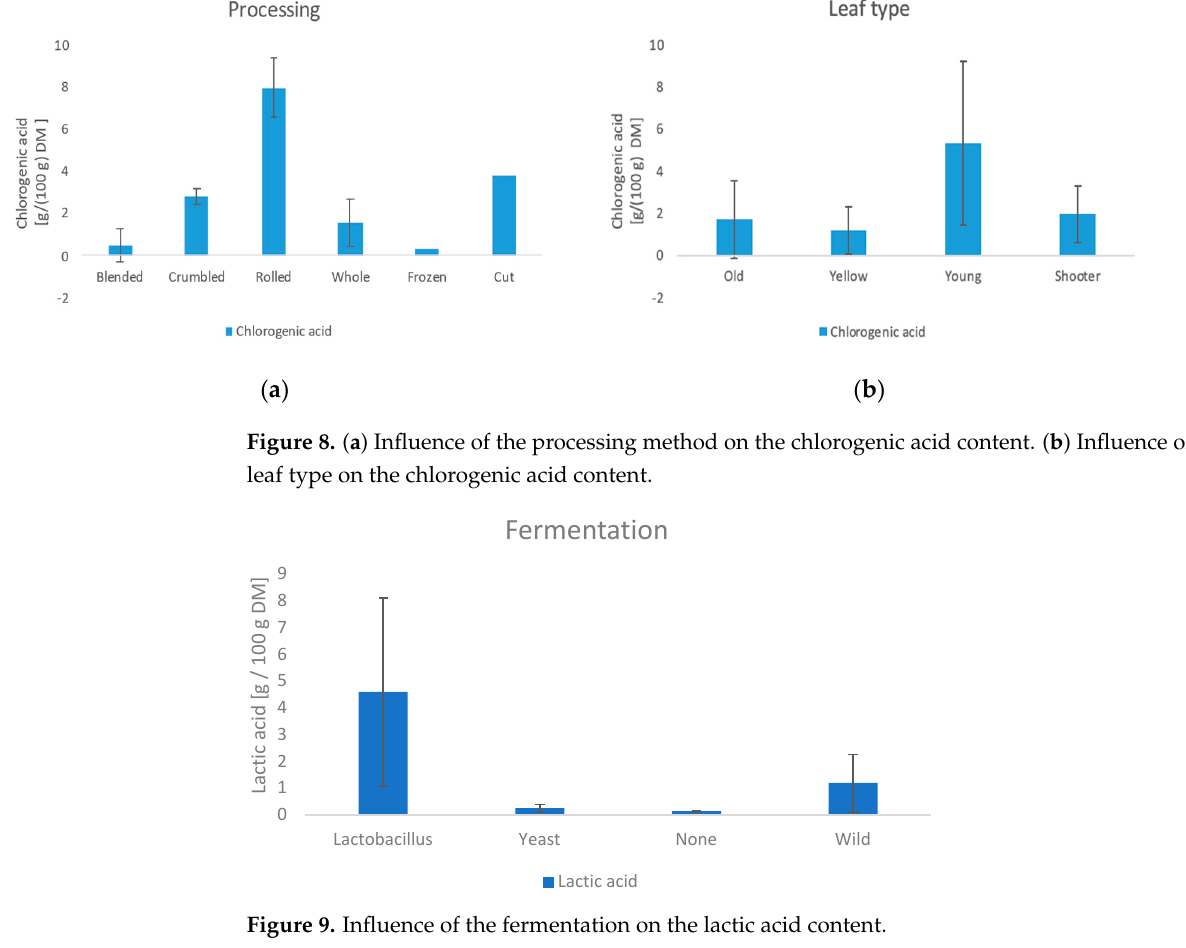
Figure 9. Influence of the fermentation on the lactic acid content.